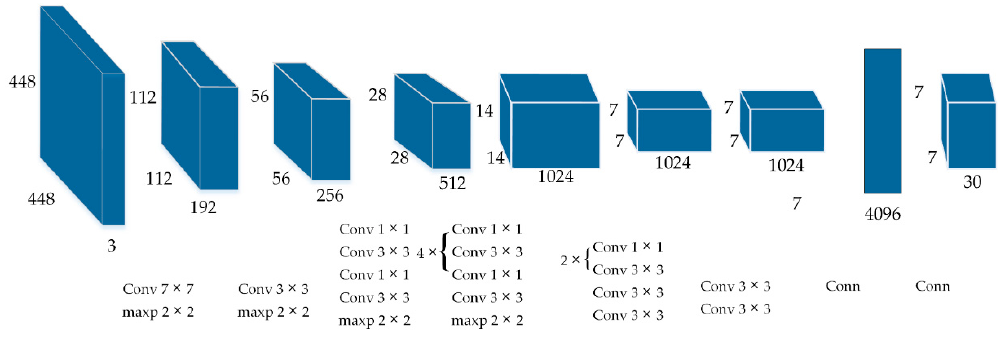
Figure 2. YOLOv1 structure.